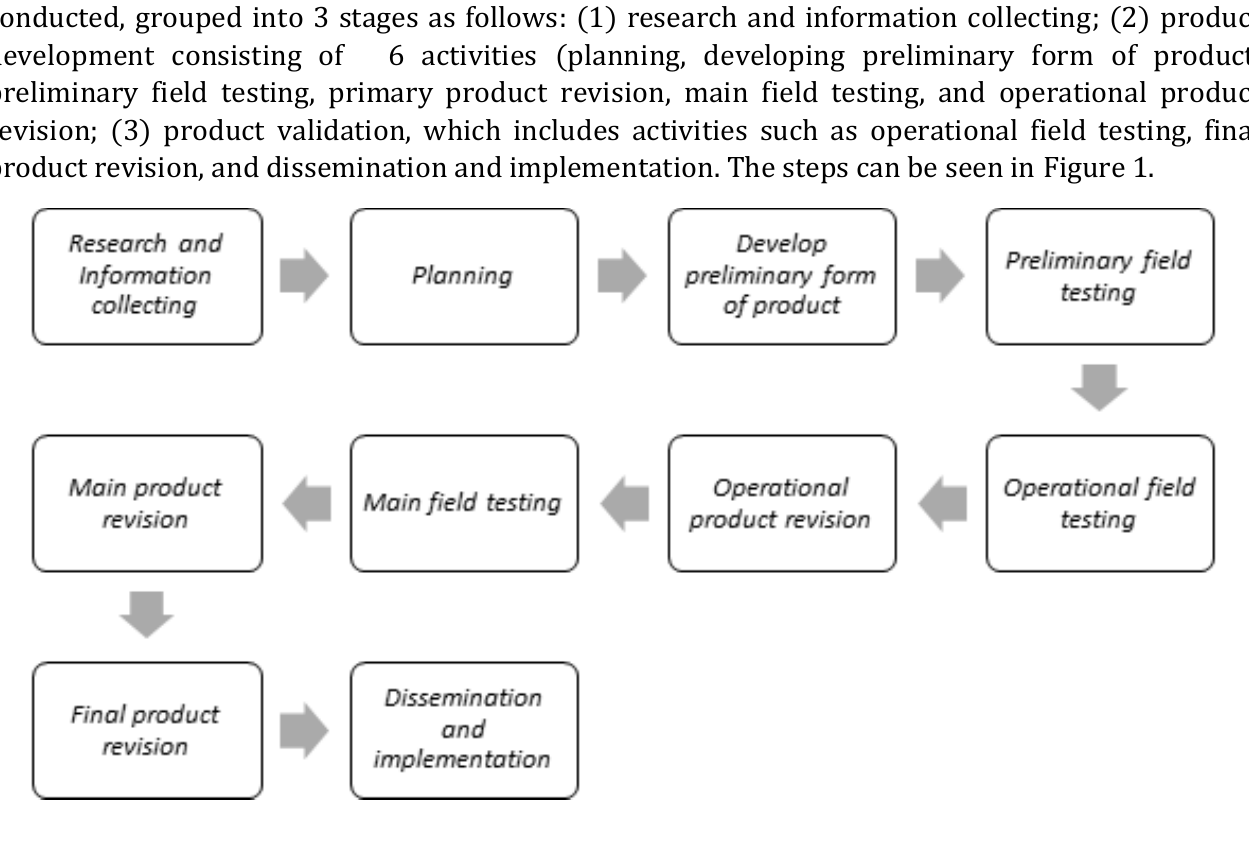
Figure 1. The Research and Development